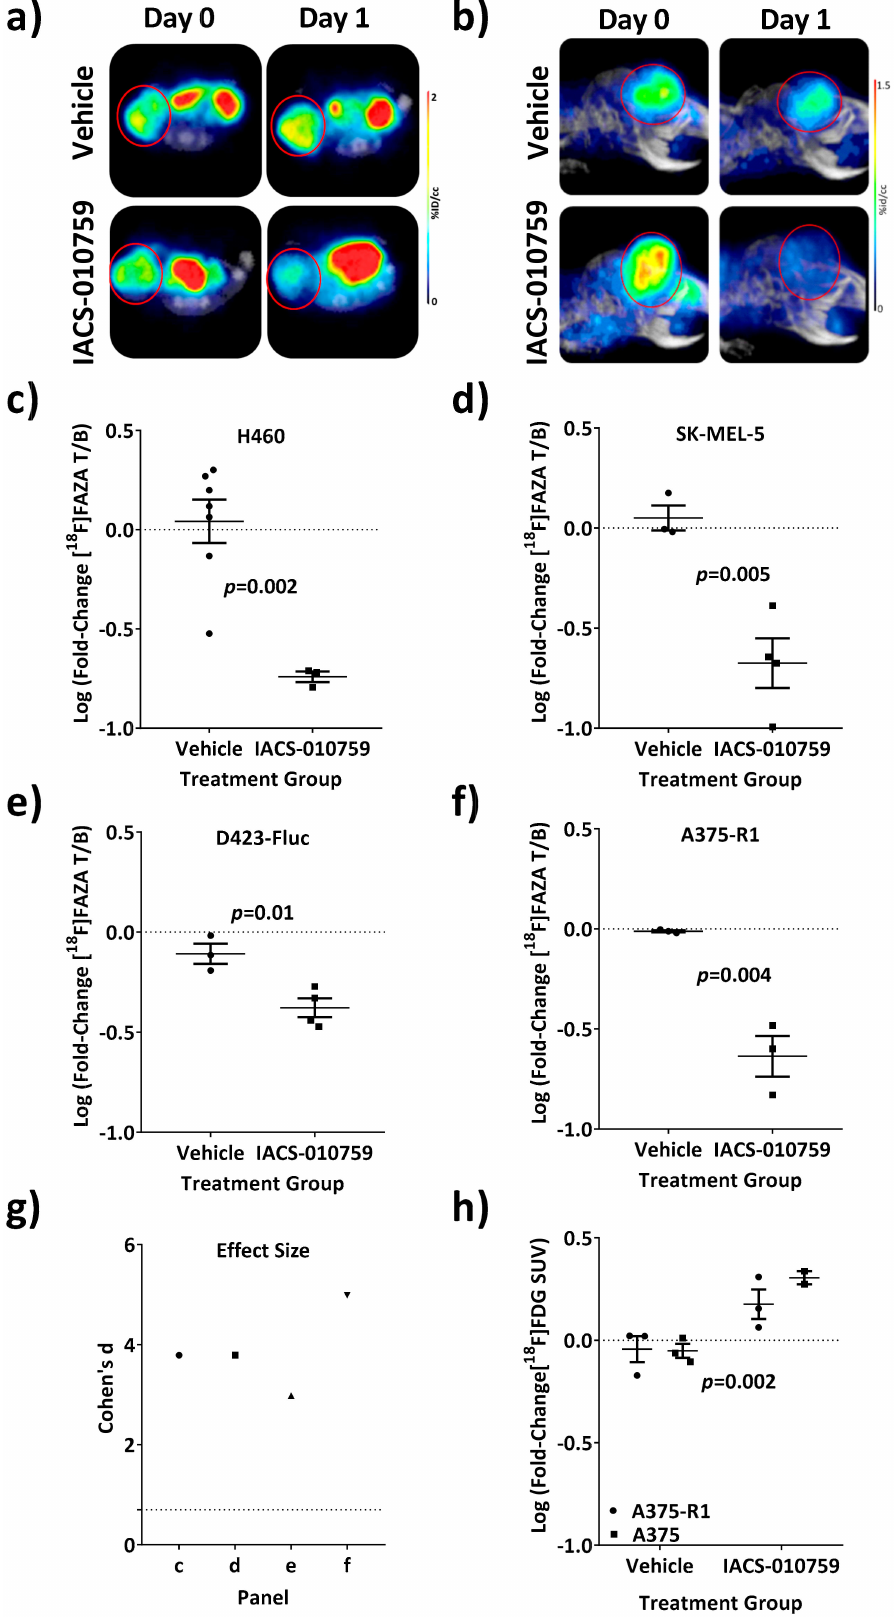
Figure 4. Animals treated at the MTD of IACS-010759 demonstrated a significant decrease in [ 18 F]FAZA retention vs. vehicle-treated animals. Prior to treatment, mice bearing ( a ) H460 NSCLC